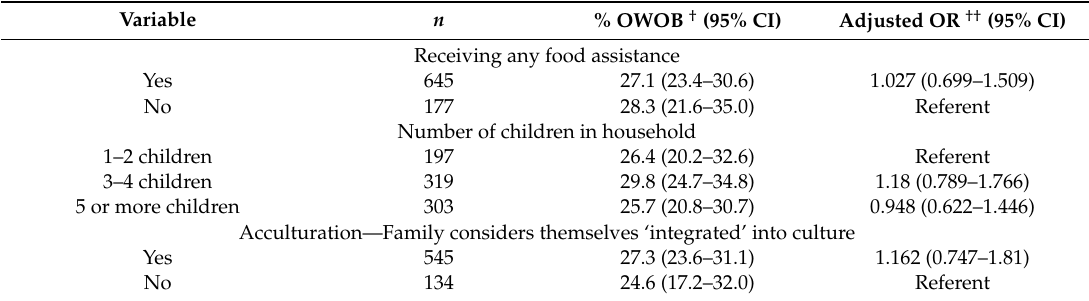
† ‘ Underweight’ children excluded from analysis, †† Adjusted for clustering by community, age, sex, and ethnicity, ‡ Consumption in cups / day, weighted for weekday / weekend days and adjusted for within person